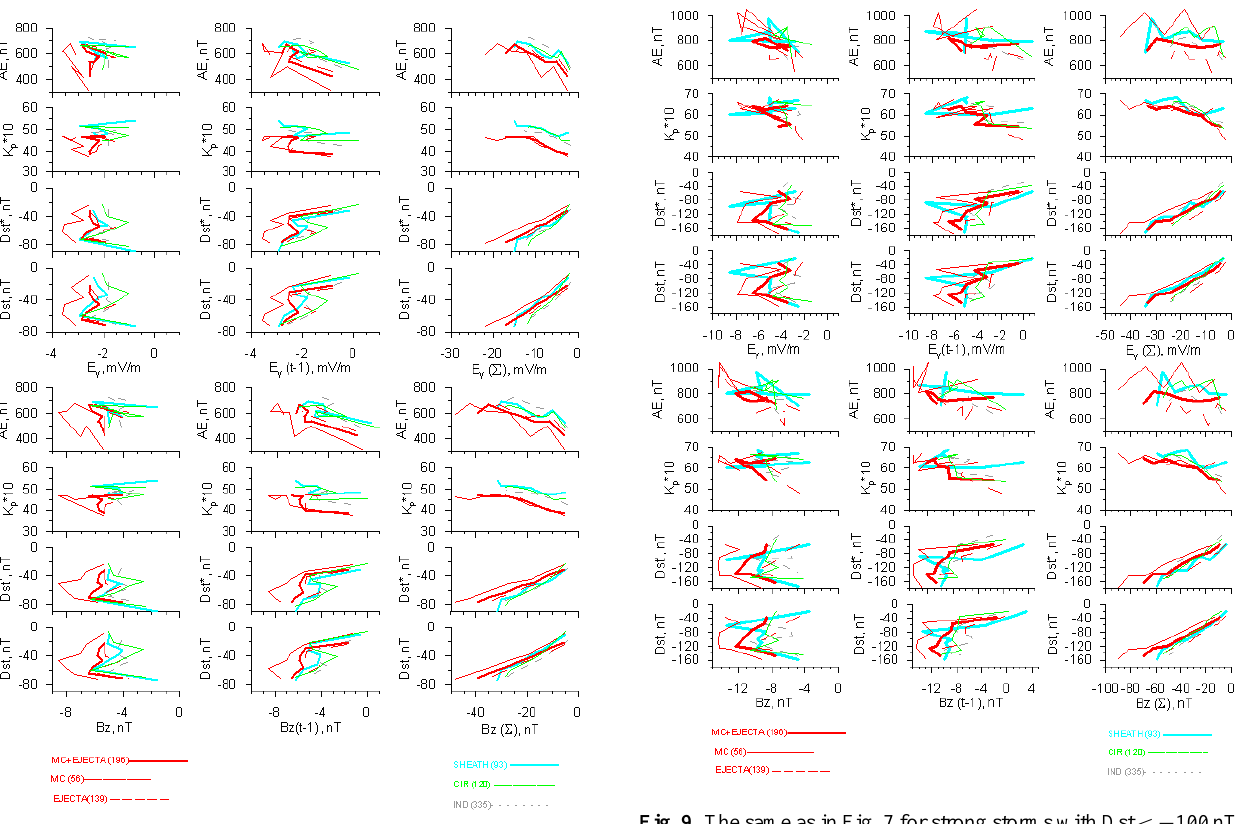
Fig. 9. The same as in Fig.7 for strong storms with Dst < -100 nT.